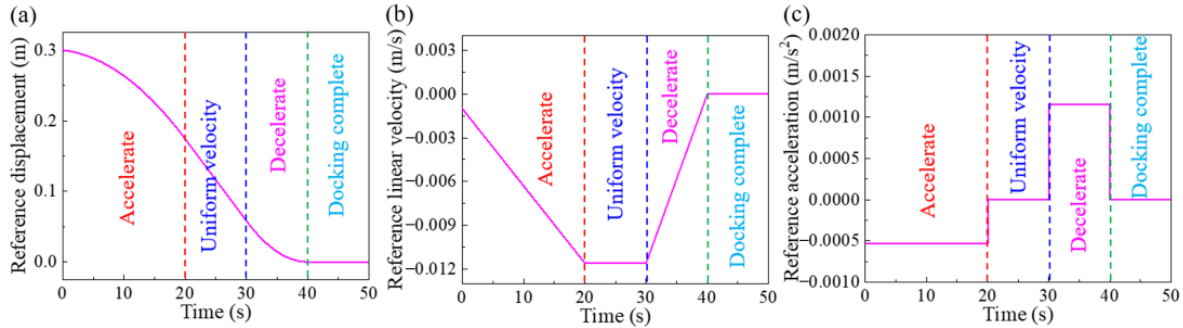
Figure 8. The reference displacement ( a ), linear velocity ( b ), and acceleration ( c ) of the subsatellite.